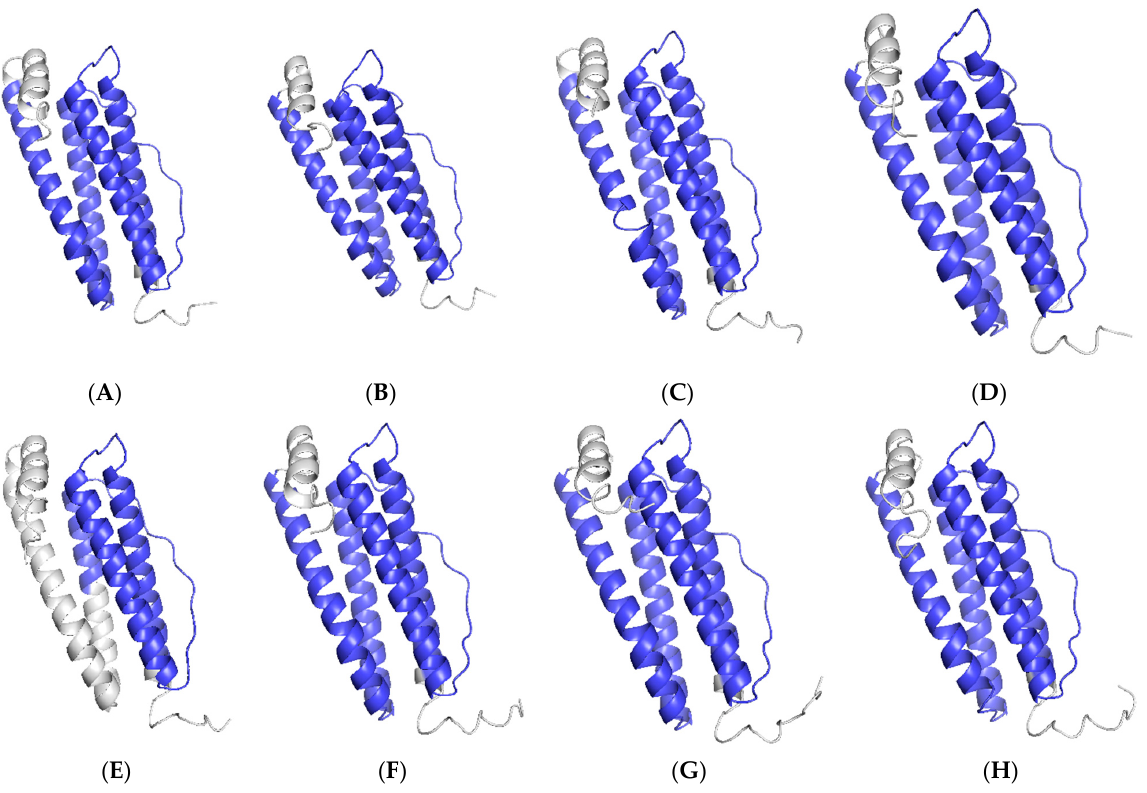
Figure 3. Tertiary structure of ferritin proteins. Ferritins from ( A ): grass carp (